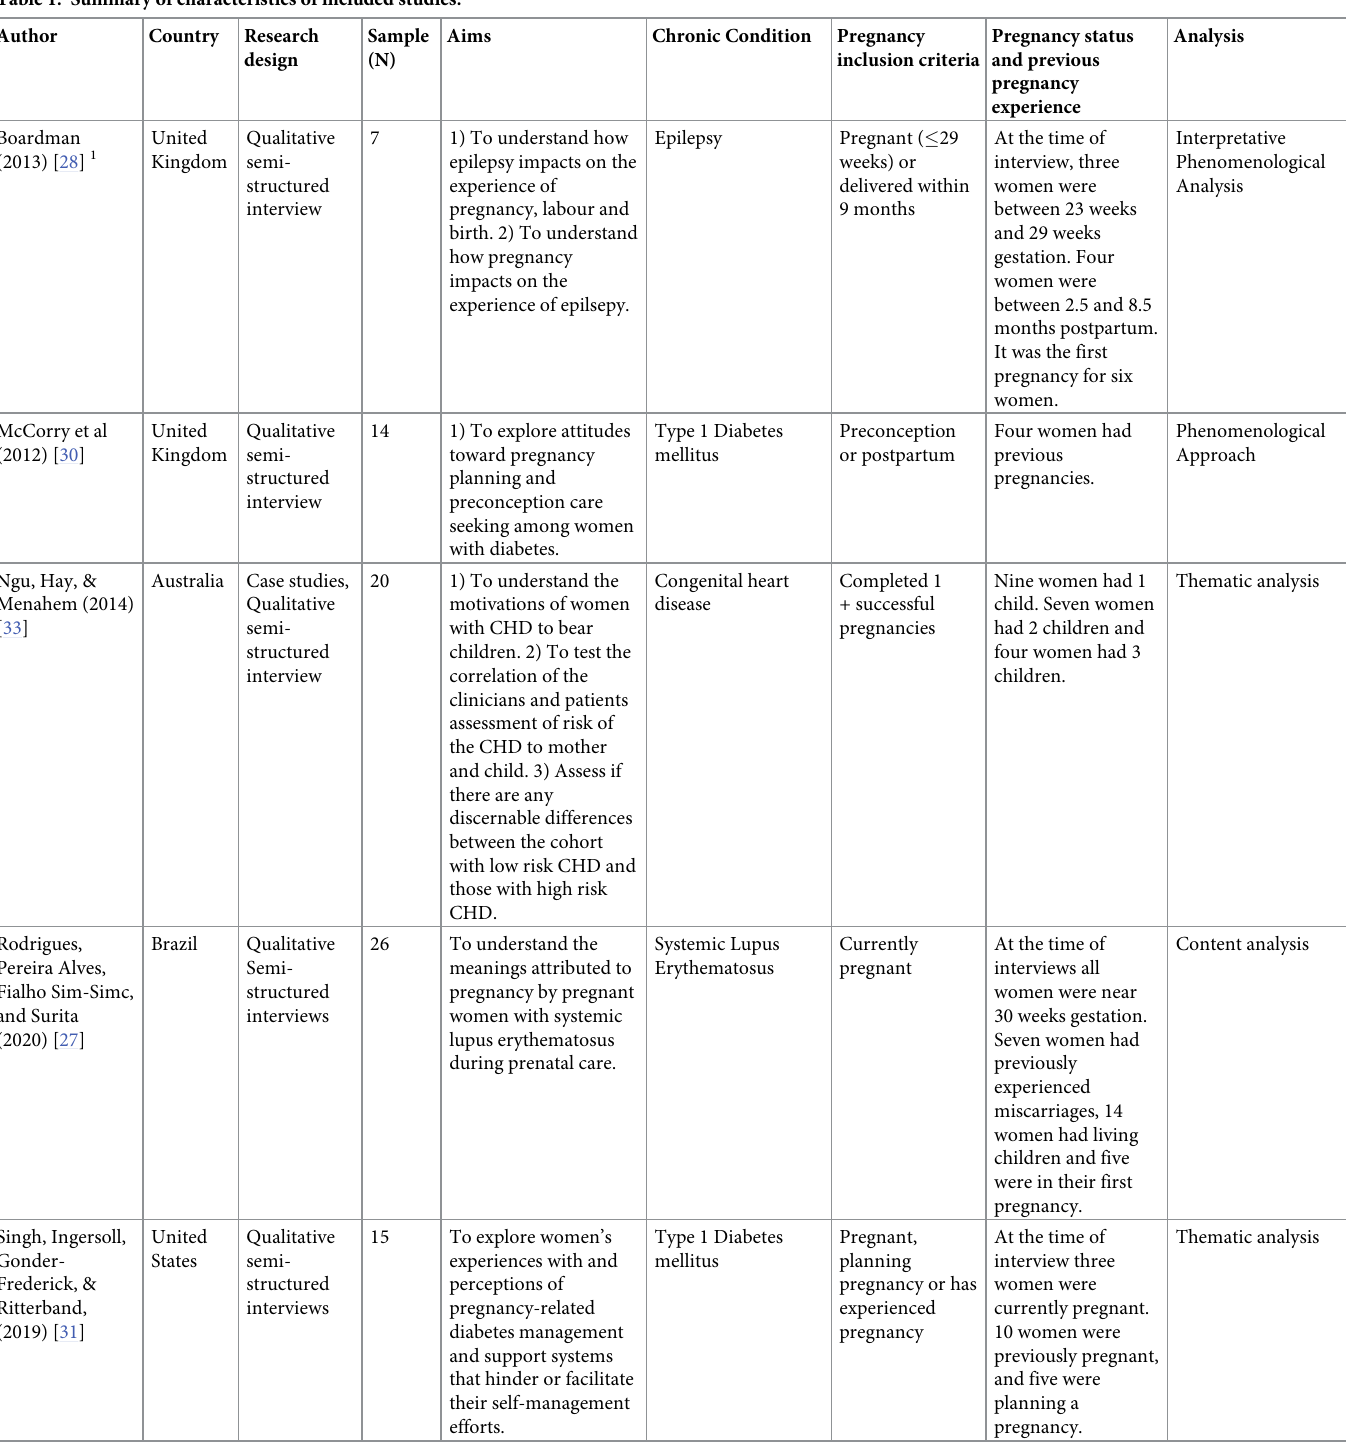
Table 1. Summary of characteristics of included